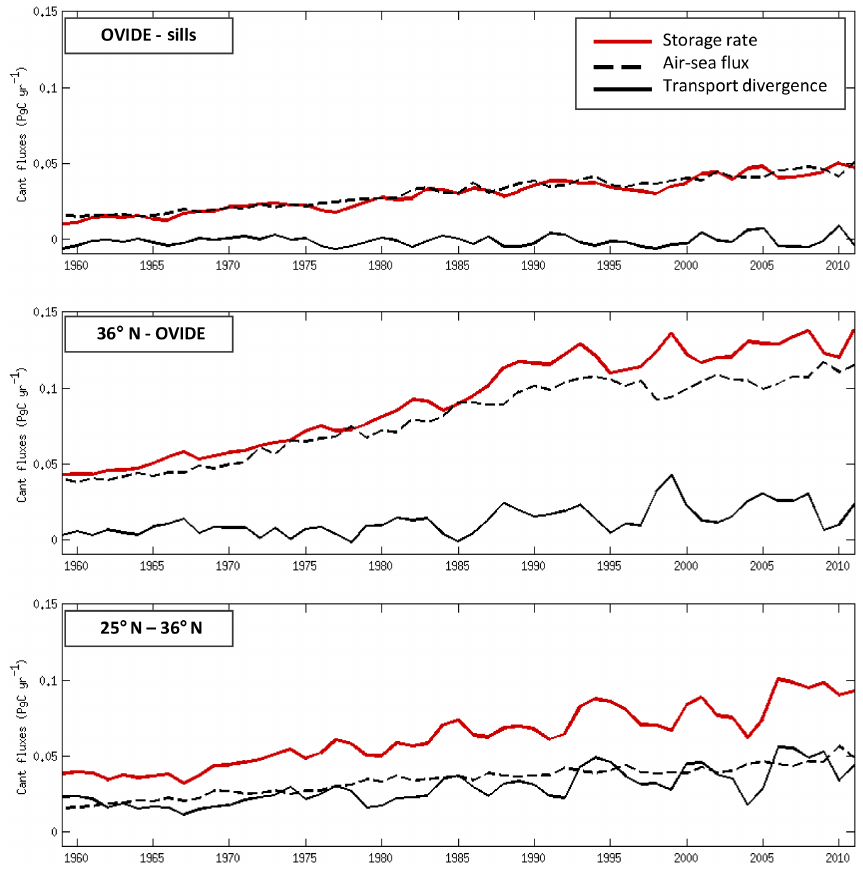
Figure 11. Annual time series of contributions to the anthropogenic carbon (Cant) budget (Pgyr − 1 ) simulated by the model (c) between 25 and 36 ◦ N, (b) between 36 ◦ N and the OVIDE section and (a) between the OVIDE section and the Greenland–Iceland–Scotland sills over the period 1959–2011. Contributions are the storage rate of Cant (red line), the air–sea flux of Cant (black dashed line) and the transport divergence of Cant (black full line). Table 5. Summary of (a–b) the coefficient of correlation (with p value) between the MOC and the transport of heat or Cant at 25 ◦ N, 36 ◦ N and the OVIDE section. The analyses were done first with the original time series ( a including trend) and with the detrended time series ( b without trend). The trend for each term as well as those of volume transport are reported in the third part of this table ( c